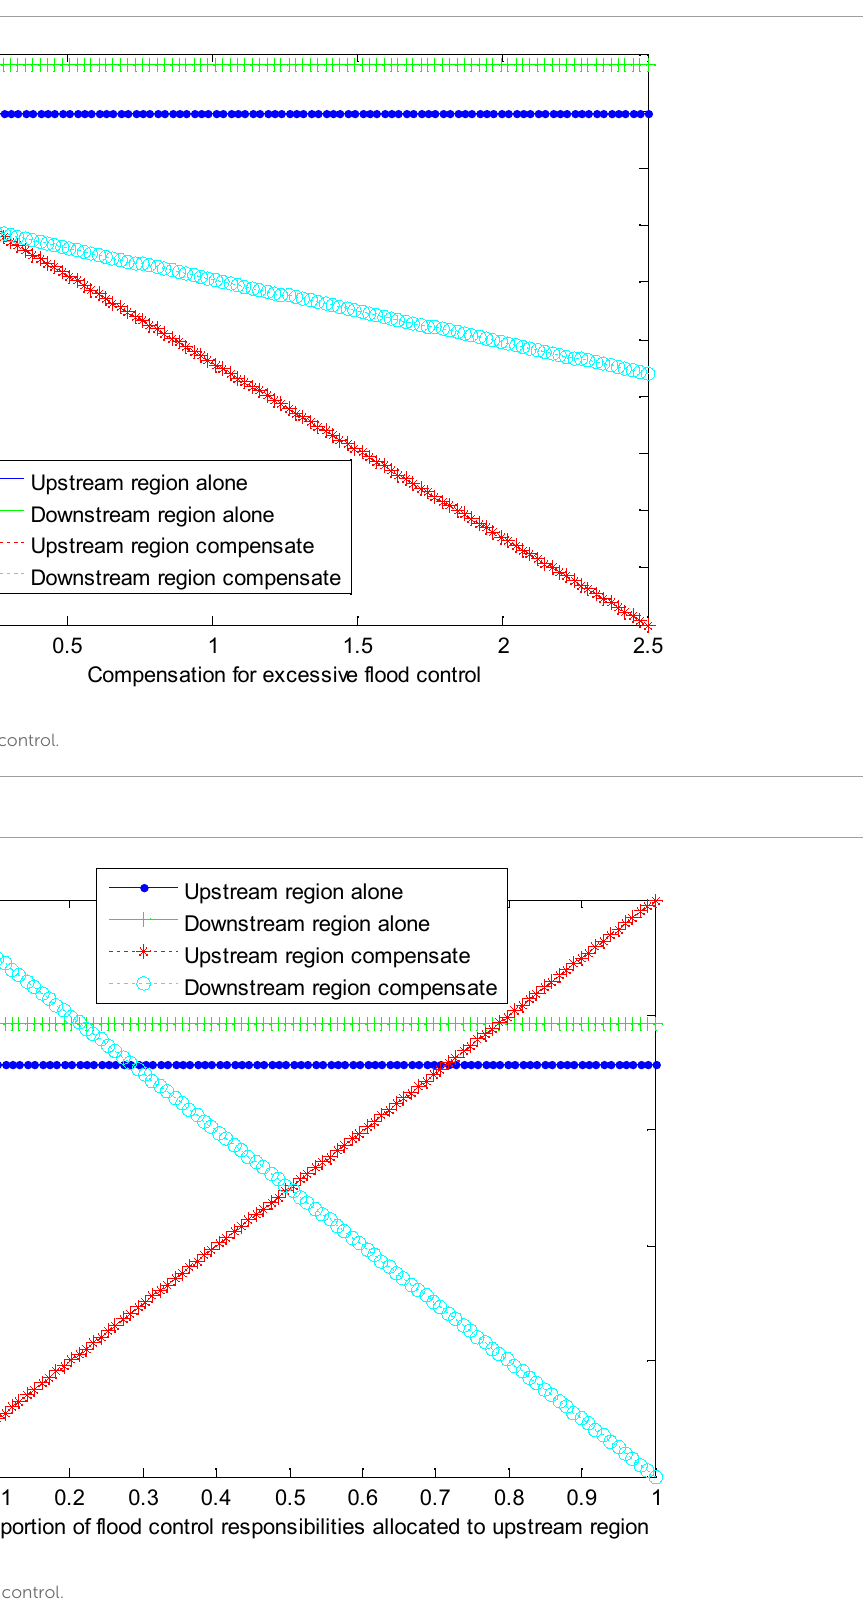
FIGURE8 The impact of allocation ratio on flood